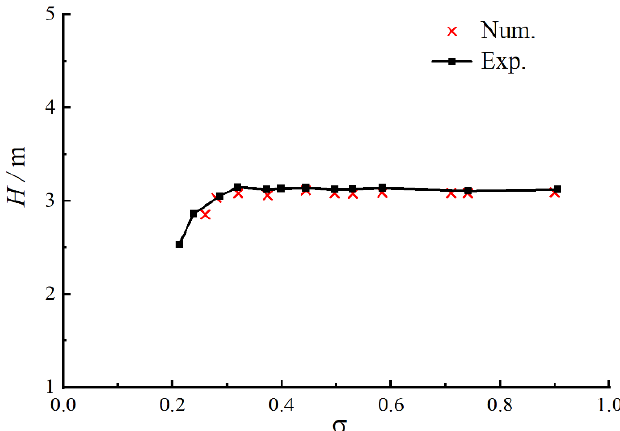
Figure 5. Comparison of the axial flow pump’s σ – H curves from the numerical simulation and experiment.